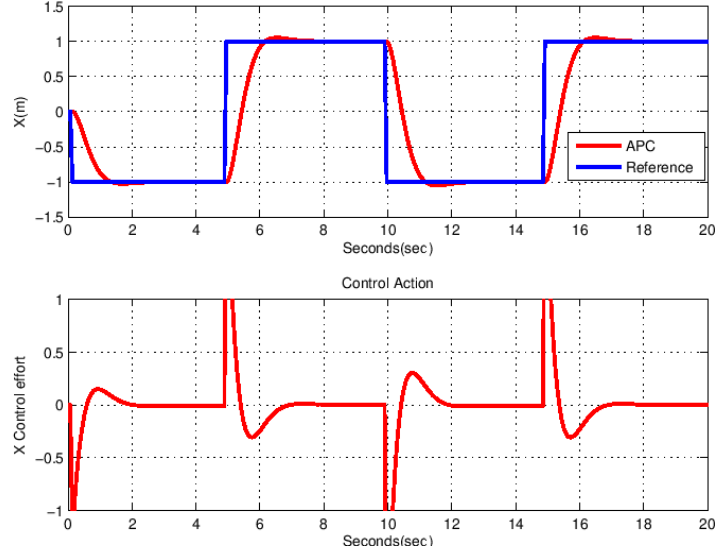
Figure 3. Result of proposed MIMO-APC controller in axis